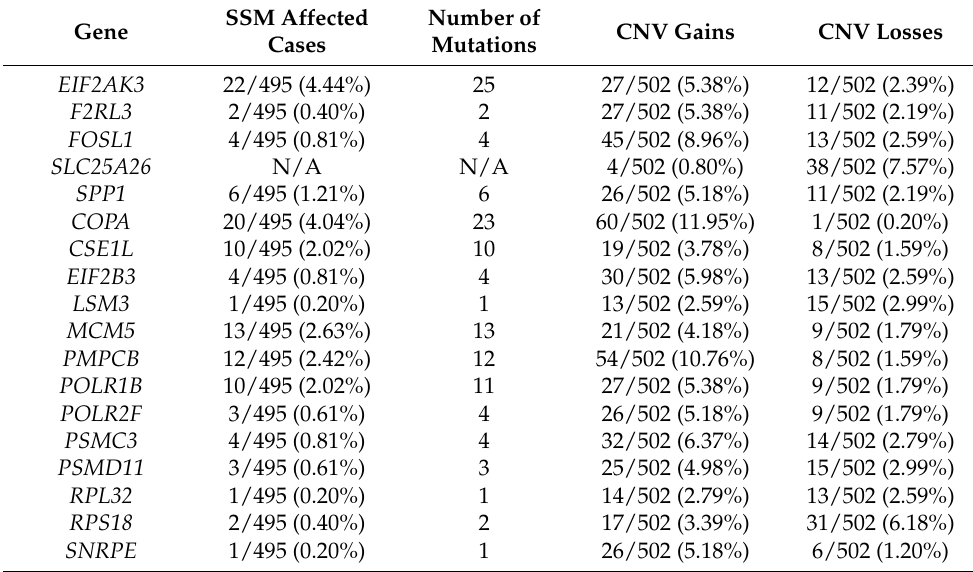
Table A2. The number of patient cases affected by CNV and mutation of the identified genes in